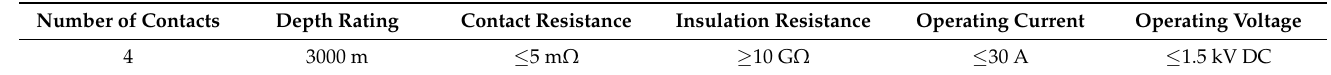
Table 1. Main specifications of the proposed wet-mateable electrical